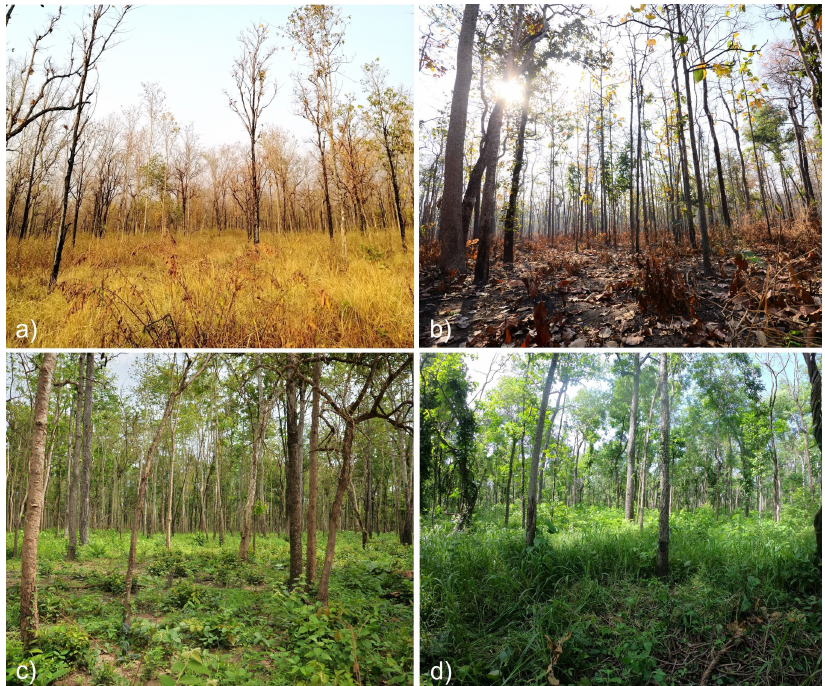
Figure 4. The season changing of forest in the Huai Kha Khaeng Wildlife Sanctuary and the Huai Thab Salao-Huai Rabum Non-Hunting Area. ( a ) During December–February, all forest condition is in the dry period, and plants drop all leaves. ( b ) The dry biomass (leaves, branches, and stems) on the forest floor was burned by prescribed burns during March–April. ( c ) After prescribed burns (begin rainy season, during May–July), most plants resprout more effectively, therefore leaves and branches of plants are new and higher quality food sources for animals. The time called “springtime”. ( d ) Mid rainy season, during August–October the parts of the plants are old and lower quality for